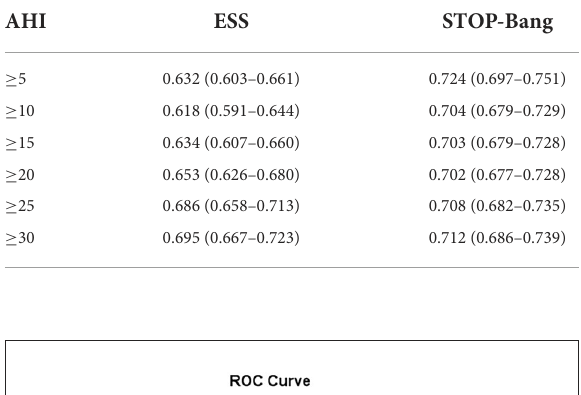
FIGURE3 ROC curve of the ESS and STOP-Bang at AHI cutoff of ≥ 15 events/h (At an AHI cutoff of ≥ 15 events/h, the diagnostic performance of the STOP-Bang is better than the ESS. AHI, apnea-hypopnea index; ESS, Epworth Sleepiness Scale; STOP-Bang, STOP-Bang questionnaire; ROC, receiver operating